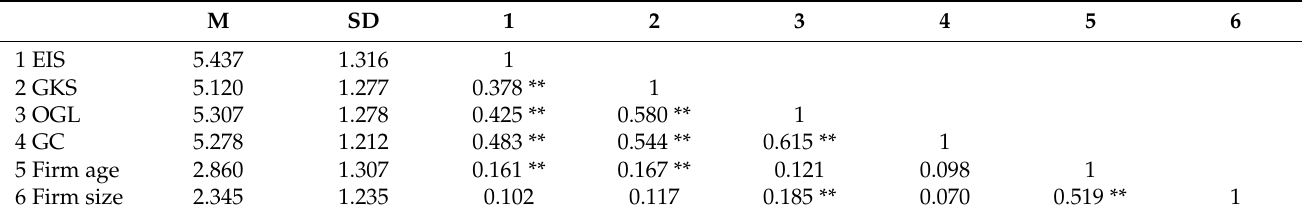
Table 3. The descriptive analysis and correlation